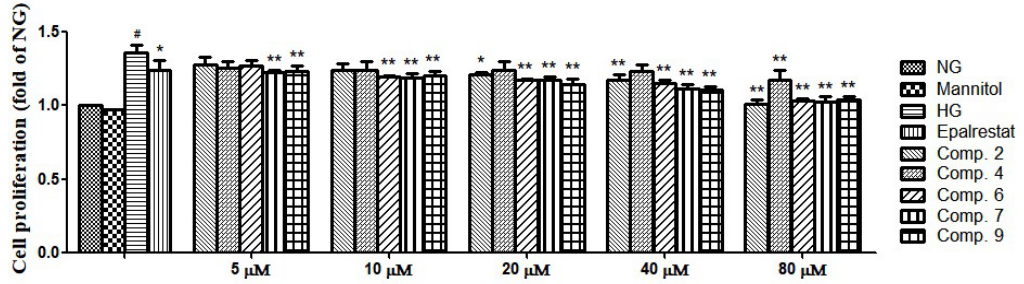
Figure 3. The rat glomerular mesangial cells (GMCs) were pretreated with various concentrations of compounds 2 , 4 , 6 , 7 , and 9 (5, 10, 20, 40, and 80 μM) and incubated for 48 h. GMCs proliferation was determined using the 3-(4, 5-dimethyl-2-thiazolyl)-2, 5-diphenyl-2-H-tetrazolium bromide (MTT) assay. Values are expressed as mean ± SD of three independent experiments, with ＃ p < 0.01 relative to the 5.6 mM glucose (normal group, NG), and ** p < 0.01, * p < 0.05 relative to the 25 mM high glucose (high-glucose group, HG).